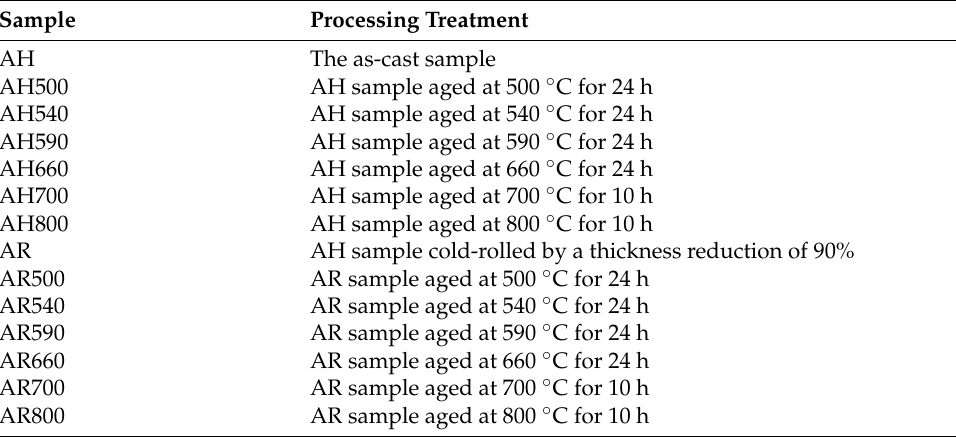
Table 1. Detailed processing parameters of the